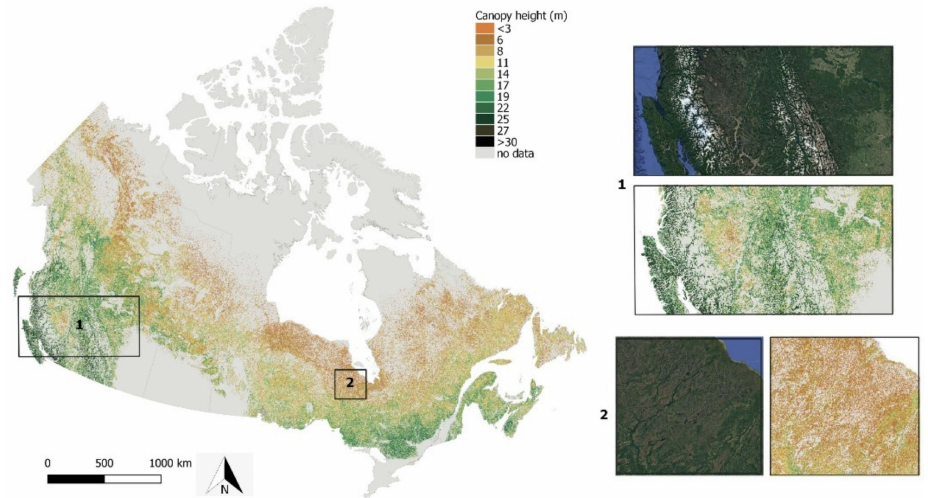
Figure 6. Forest canopy height map for the year 2020 produced through the integration of GEDI data (June–August 2020) and covariates derived from Sentinel and PALSAR-2. Close-up examples with google satellite images illustrating ( 1 ) forests in the Pacific Maritime and Montane Cordillera ecozones, ( 2 ) peatlands in the Hudson Plain